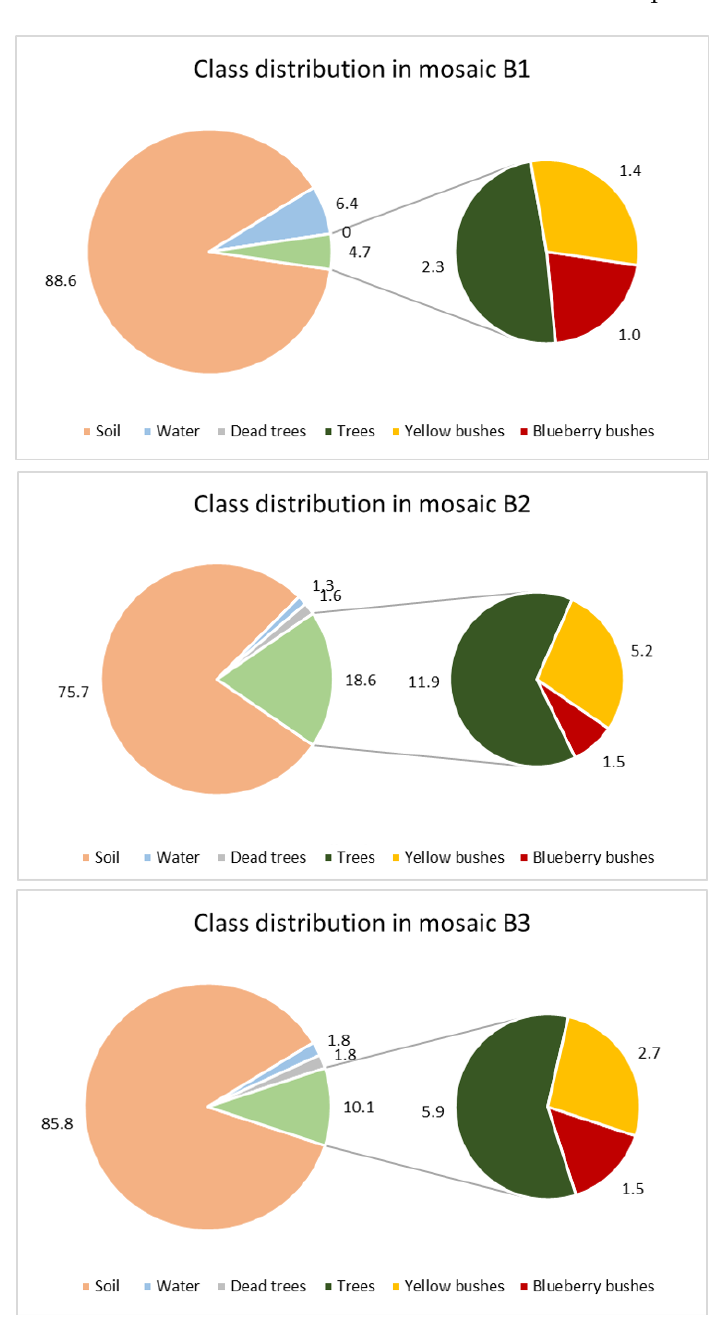
Figure 4. Distribution of annotated classes for the orthomosaics B1 to